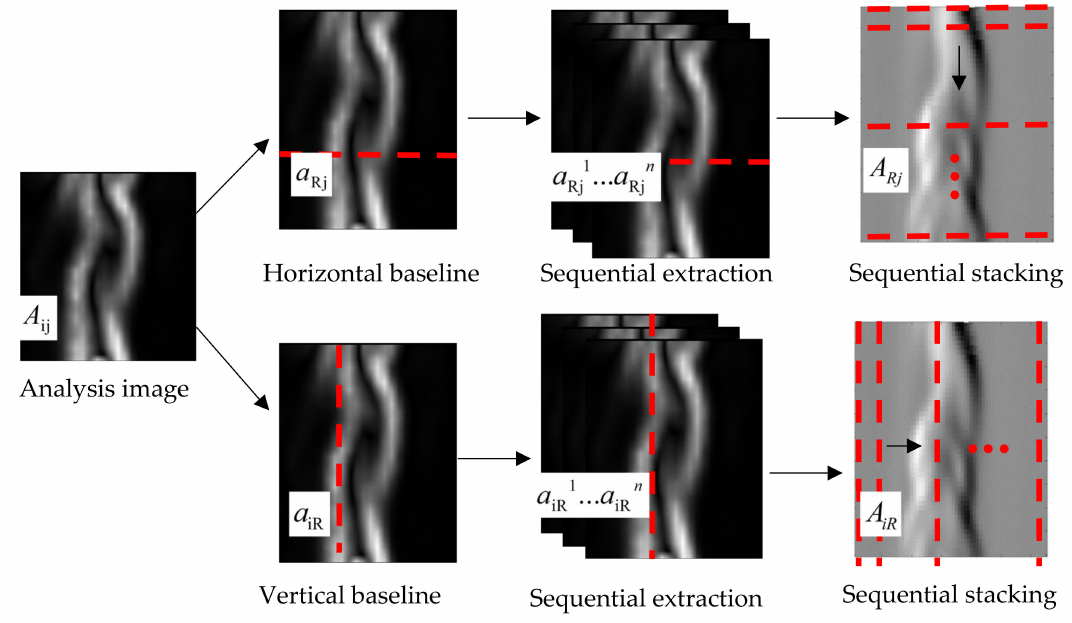
Figure 6. Time series baseline stacking